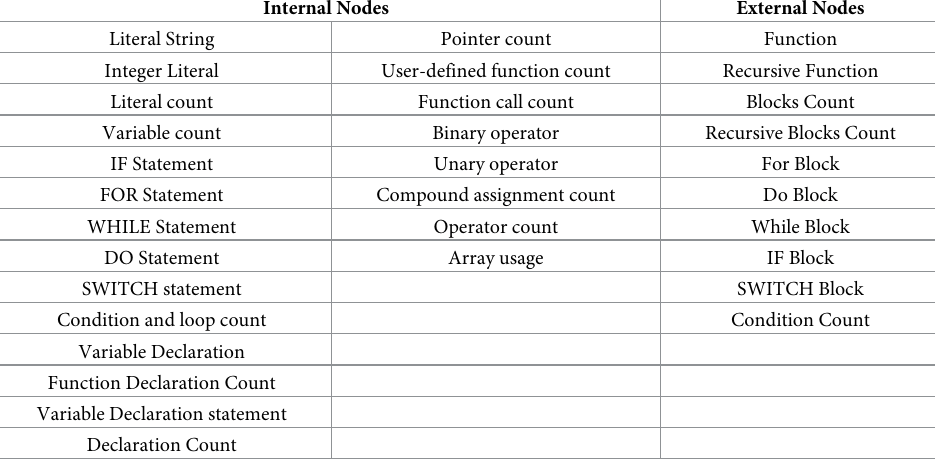
Table 1. The selected metric nodes of